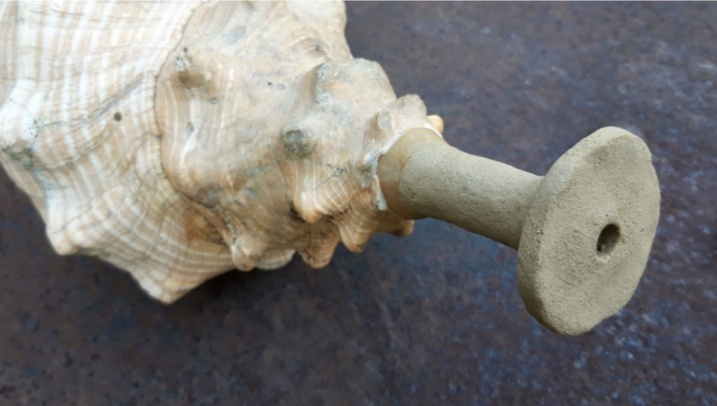
Figure 7. Shell horn made from Triplofusus princeps . Experimental model with ceramic discoidal mouthpiece created by the author (2021).